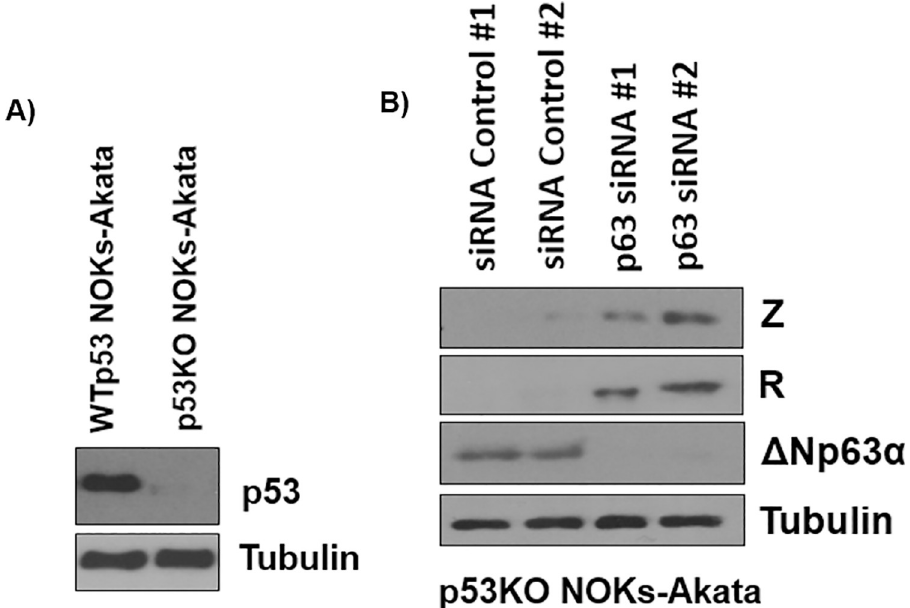
Fig 5. Δ Np63 inhibits lytic reactivation in NOKs-Akata cells even when the p53 gene is deleted. A) The CRISPR/ CAS9 technique was used to knock out p53 expression in NOKs-Akata cells, as described previously [73], and expression of the p53 protein and tubulin loading control was examined by immunoblot to confirm knock-out of p53 expression. B) NOKs-Akata cells in which the p53 gene was knocked-out were transfected with siRNAs against Δ Np63 α or a control sequence. Two days later expression of the Z, R, Δ Np63 α and tubulin proteins was examined by immunoblot. These results are representative of three biological replicate experiments.